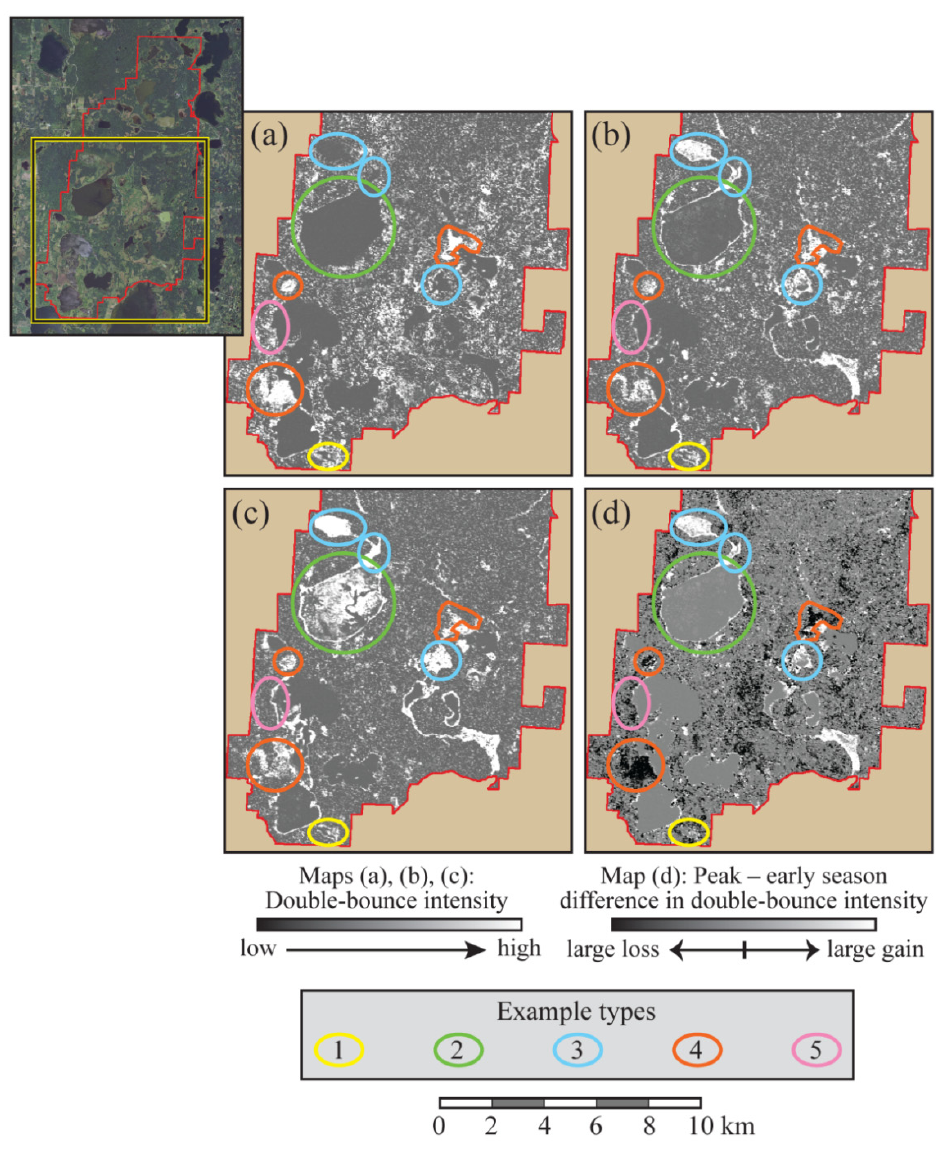
Figure 7. Changes in intensity of double-bounce backscatter over the 2009 growing season. ( a ) Early-season overpass on 15 May; ( b ) peak-season overpass on 26 July; ( c ) late-season overpass on 12 September; and ( d ) difference between peak- and early-season intensity of double-bounce backscatter. Example types correspond with those referenced in Section